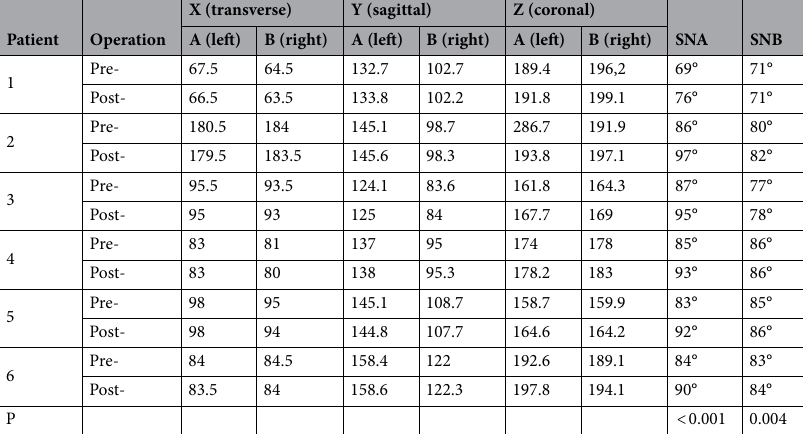
Table 2. Three-dimensional spatial position and SNA and SNB angles of the preoperative and postoperative traction hook placement points. It can be seen that through the maxillary traction surgery, there is little change in the position of the bilateral traction points to the transverse axis and sagittal axis, but there is a significant difference to the coronal axis, indicating a significant anteriority of the maxilla. By preoperative and postoperative SNA and SNB angle measurements, it can also be seen that there is a significant anteriority of the maxilla and no significant change in the mandible, with significant improvement in the